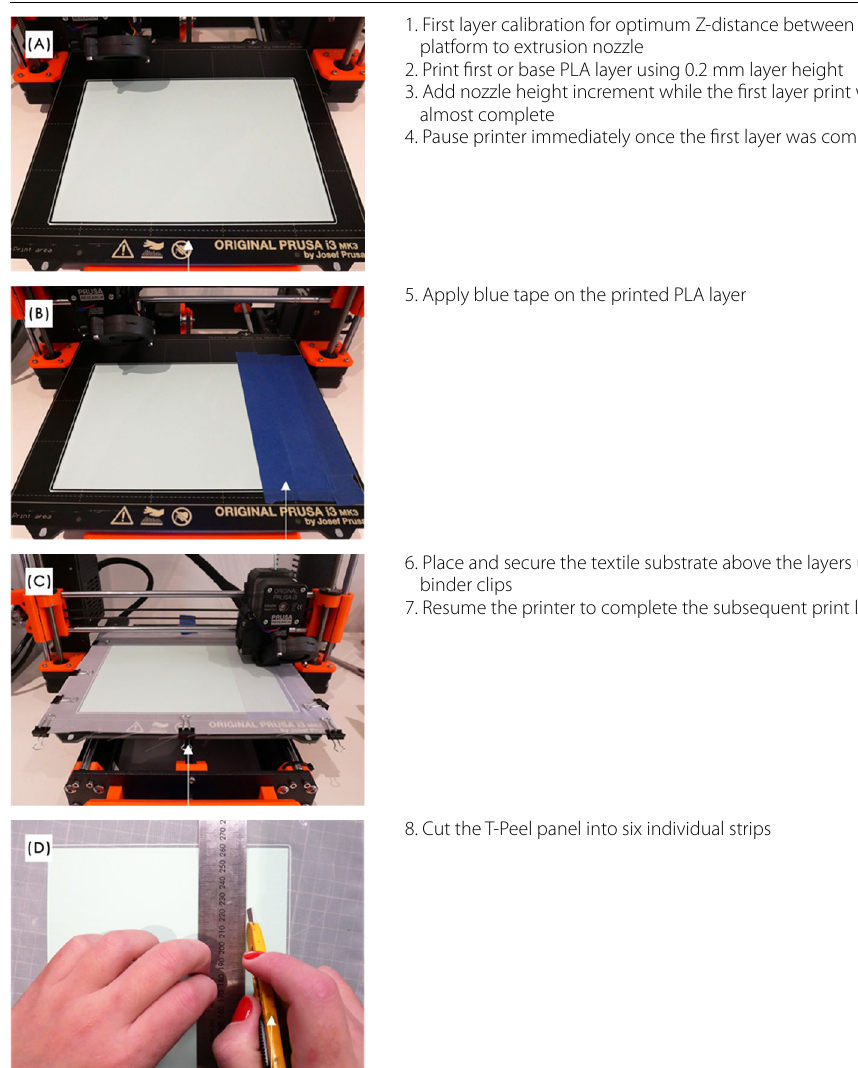
Table 7 The printing procedure involved in manufacturing ME polymer–textile composite (print layout A) to create T-Peel test